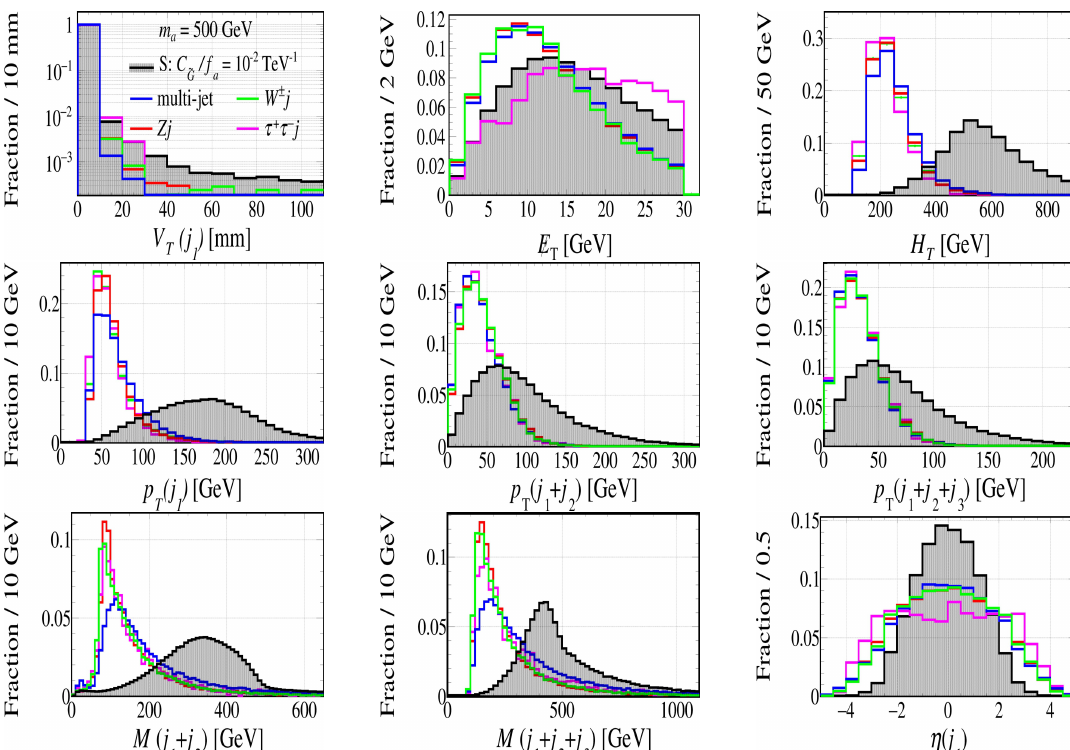
Figure 8 . Distributions of representative observables used as input to the multivariate analysis for the benchmark mass m a = 500 GeV and parameter C ˜